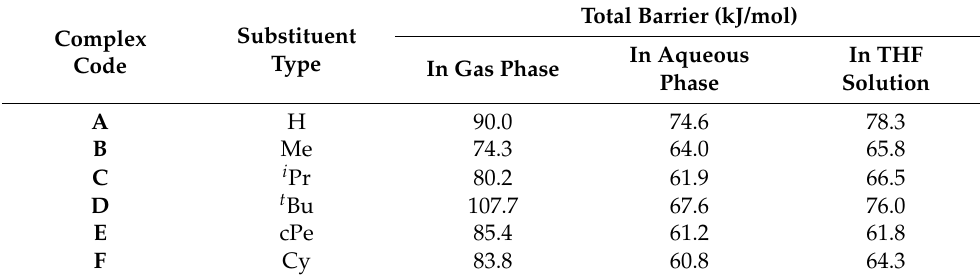
Table 6. Total barriers for CO 2 hydrogenation to formate on six Ru-PNP complexes with different substituents in gas phase, aqueous phase, and THF